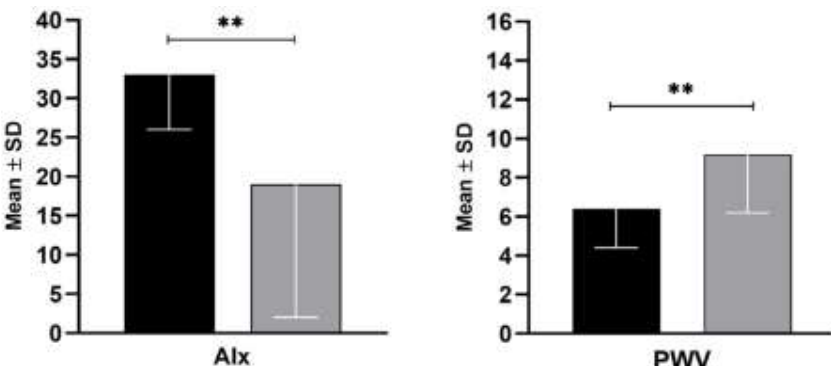
Figure 1. Augmentation Index (Alx) and Carotid-femoral Pulse Wave velocity (cf-PWV) in SSc patients (in black) and controls (in grey). Data are expressed as mean and standard deviation (SD). The p -values were calculated by the Mann-Whitney U test non-parametric test (** p < 0.01).